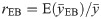
For the simulated population, bias index of the El-Badry estimator as a function of the nonresponse rate at the last phase (detail for moderate nonresponse rates).Curve of the bias index rEB=E(y¯EB)/y¯ based on 100 000 simulations of the nonresponse mechanism, for L = 2, 3, 4, πz = 0.2, πm(i) = 0.85 for 1 ≤ i < L, and πm(L) = 0(0.01)0.1 (black dots
L = 2; white circles
L = 3; black triangles down
L = 4). Details in the text.